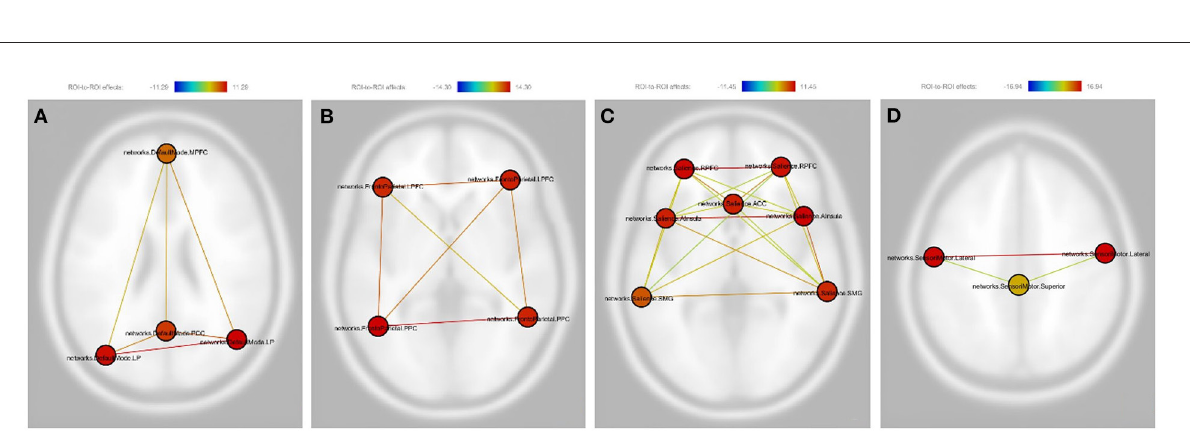
FIGURE2 Pictorial demonstration of the results of linear mixed effects of depression in post vs. pre-therapy connectivity. The involved are the following: (A) Default mode network: PCC, Posterior cingulate cortex; LP (L), left lateral parietal cortex; LP (R), The right lateral parietal cortex; MPFC, Medial prefrontal cortex. (B) Frontoparietal network: PPC (L), The left posterior parietal cortex; PPC (R), The right posterior parietal cortex; LPFC (L), The left lateral prefrontal cortex; LPFC (R), The right lateral prefrontal cortex. (C) Salience Network: RPFC (L), The left lateral rostral prefrontal cortex; RPFC (R), The right lateral rostral prefrontal cortex; ACC, Anterior cingulate cortex; SMG (L), The left supramarginal gyrus; SMG (R), The right supramarginal gyrus; AInsula (L), The left anterior insula; AInsula (R), The right anterior insula. (D) Sensorimotor network: lateral (L), the left lateral region in the sensorimotor network; lateral (R), the right lateral region in the sensorimotor network; Superior: The superior region in the sensorimotor network. The color bar represents the effective connectivity between each node (edge color) and the color of each node means the sum of the effective connectivity of its significant